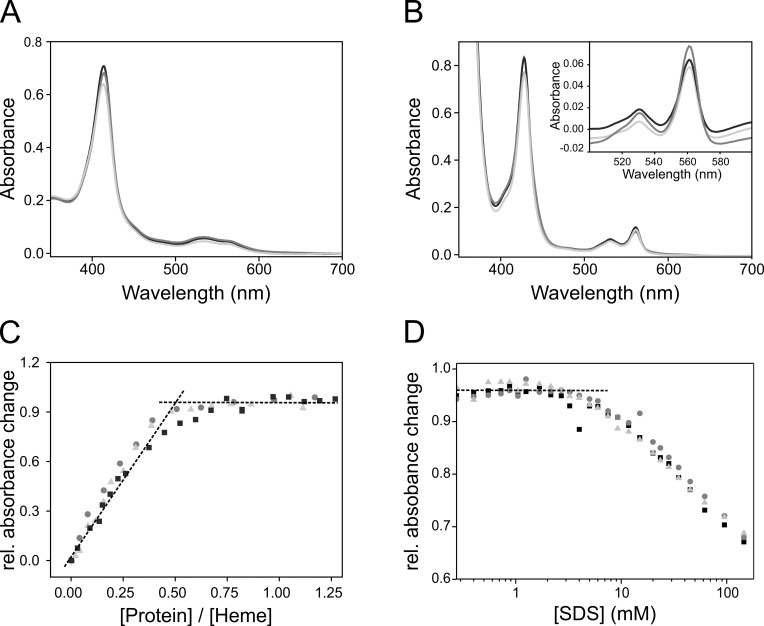
In vitro reconstitution of cyt. b6 and its Gn-mutants containing prolonged BC loops.Absorbance spectra of in vitro reconstituted cyt. b6 (black), cyt. b6-G5 (dark gray) and cyt. b6-G10 (light gray) under oxidizing (A) and reducing (B) conditions. G5 and G10 stands for the number of Gly residues inserted into the BC-loop. The absorbance maxima are essentially identical for all three proteins (A: 561 nm / 532 nm / 414 m; B: 562 nm / 532 nm / 429 nm for the α-/β-/γ-band). The same applies for the redox difference spectra (562 nm / 532 nm for the α-/β-band) (inlet B). (C) and (D) show titrations of cyt. b6 (black squares), cyt. b6-G5 (dark gray spheres) and cyt. b6-G10 (light gray triangles) with heme (C) or SDS (D) under oxidizing conditions. Each data point represents an individual measurement. The quotient of the absorbance intensity at 414 nm to 404 nm was calculated, representing the absorbance maximum of the Soret-band of bound and unbound heme, respectively, and normalized to “0” for solely free heme and “1” for solely bound heme. (C) Increasing amounts of protein were titrated into buffer containing 5 μM heme to measure heme-binding isotherms. For all three proteins, the titration experiments show a saturation at a protein/heme ratio of 0.5 and higher. (D) To determine the proteins´ stability, increasing amounts of SDS were added to reconstituted protein. All three cyt. b6 variants are stable up to an SDS concentration of ~4.5 mM.